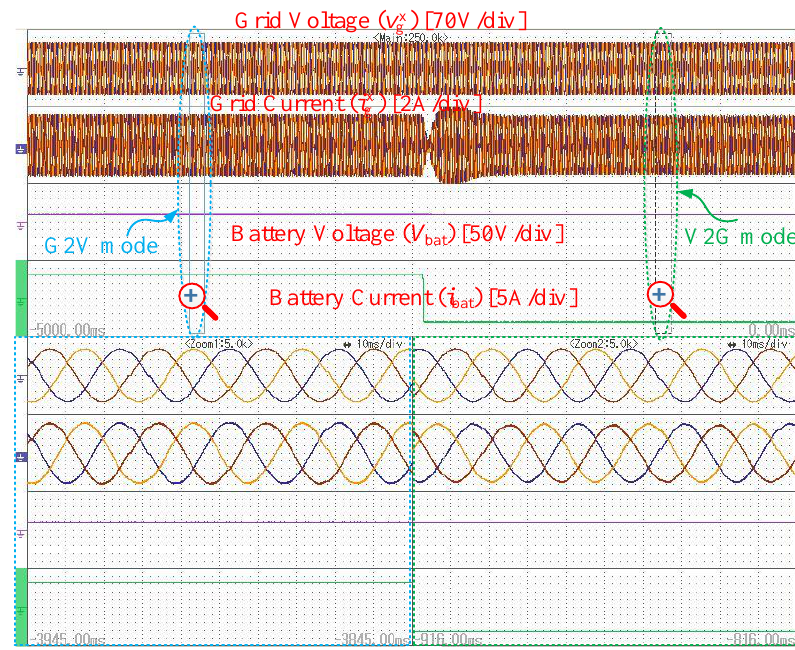
Figure 18. Bidirectional power flow with the proposed rectifier for V2G application.